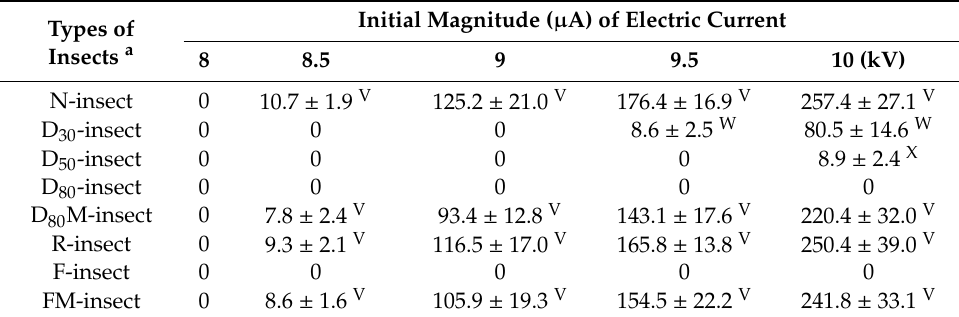
Table 2. Initial magnitude of electric current through temperature-treated houseflies exposed to a corona discharge in the dynamic electric field producer (DEP) negatively charged with di ff erent voltages.